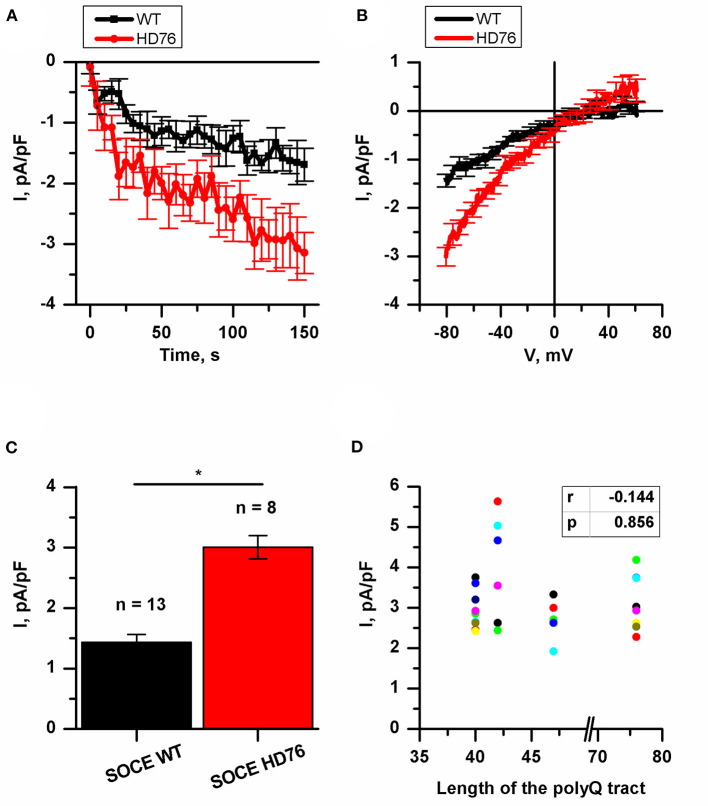
Disturbance of SOCE in HD76 neurons. (A) Normalized SOC currents evoked by application of thapsigargin (1 μM) and plotted as a function of time in HD76 (red circles), and WT (black squares) GABA MSNs. SOC currents were measured every 5 s at a test potential of −80 mV. Each trace shows mean ± SEM. (B) Average Current-Voltage relationships (I–V curves) of normalized currents evoked by passive depletion of calcium stores with thapsigargin (1 μM) in HD76 (red line), and WT (black line) GABA MSNs. The I–V curves were plotted after the full development of the SOC currents. The number of experiments is depicted at the panel (C). (C) Average amplitude or the normalized SOC currents determined at a test potential of −80 mV for HD76 (red), and WT (black) GABA MSNs. The amplitudes are plotted as the mean ± SEM (n = number of single cell experiments). The asterisks indicate that differences in amplitudes are statistically significant (p < 0.05) (D) Correlation between the amplitude of SOC currents and the length of the polyglutamine tract of mutant huntingtin. The correlation coefficient (r) and the p-value are indicated above the plot. The cell lines are represented in Supplementary Table 1.